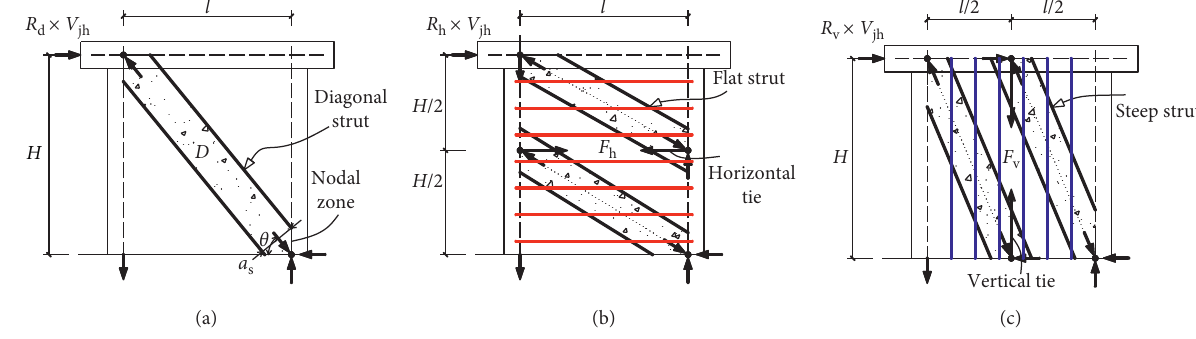
Figure 6: Shear resisting mechanisms of web. (a) Diagonal. (b) Horizontal. (c) Vertical.